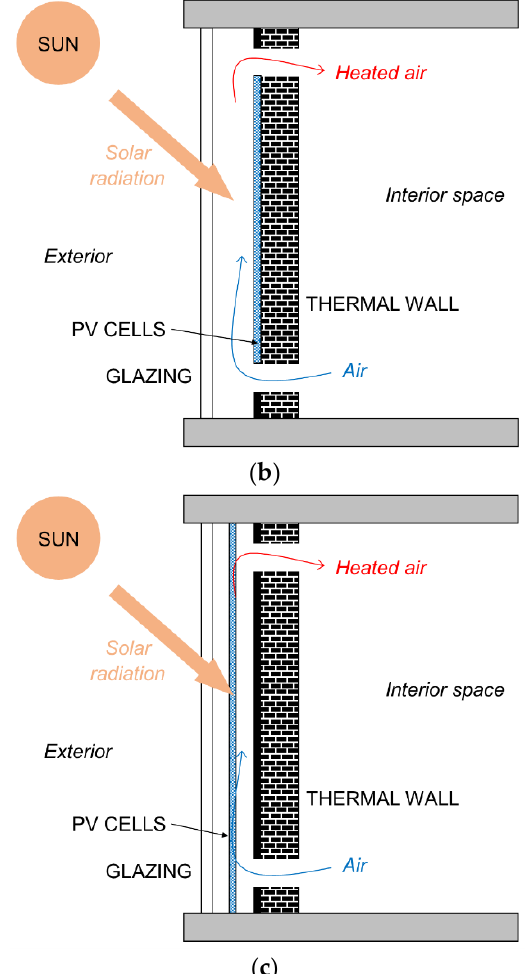
Figure 5. Schematic of a Trombe wall with incorporated photovoltaic solar cells: PVGTW ( a ), PVMTW ( b ), and PVBTW ( c ).